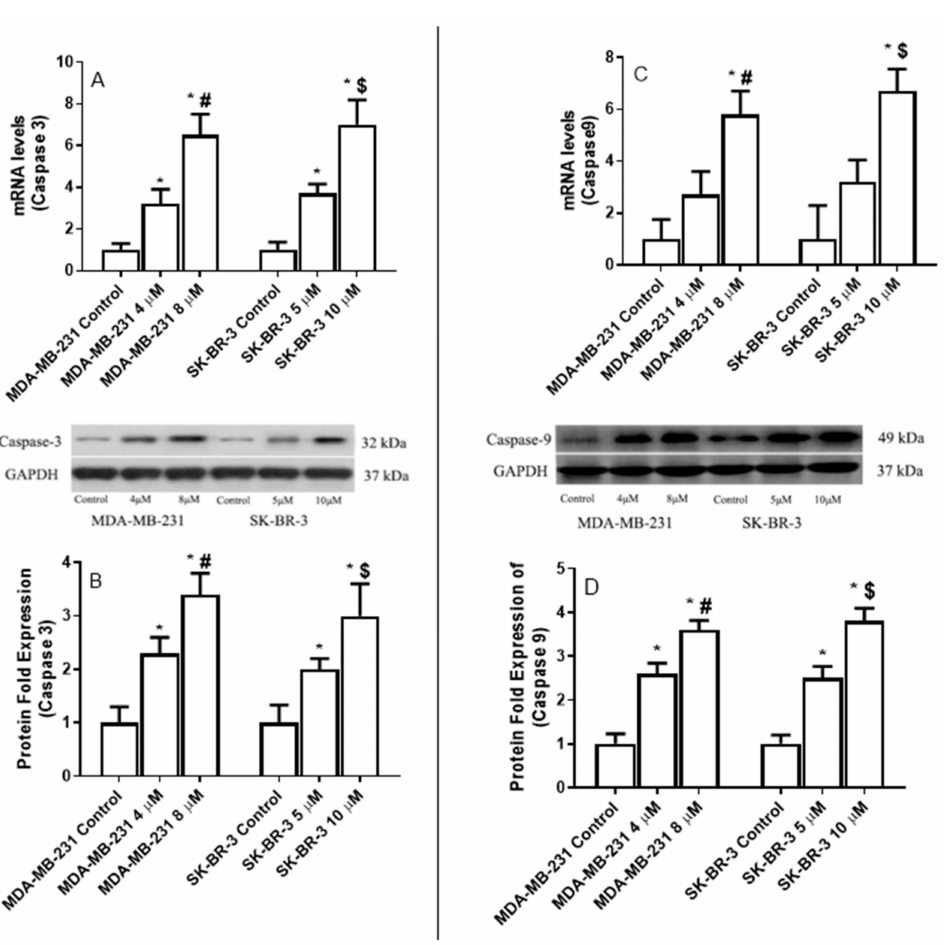
Figure 9. The effect of eugenol treatment on caspase-3 and caspase-9 mRNA and protein expression levels. MDA-MB231 and SK-BR-3 cells were treated for 24 h ( A , B ). Thereafter, caspase-3 and caspase-9 mRNA expression levels were quantified by RT-PCR. The protein expression levels of caspase-3 and caspase-9 were then assessed in MDA-MB231 and SK-BR3 cells treated for 24 h with 0, 4, and 8 µ M and 0, 5, and 10 µ M eugenol, respectively ( C , D ). * indicates a significant change compared to untreated cells (0 µ M), # indicates a significant change from MDA-MB-231 at eugenol concentration 4 µ M, and $ indicates significant changes from SK-BR-3 treated with 10 µ M eugenol at p < 0.05 based on a one-way ANOVA and the Tukey–Kramer post-ANOVA